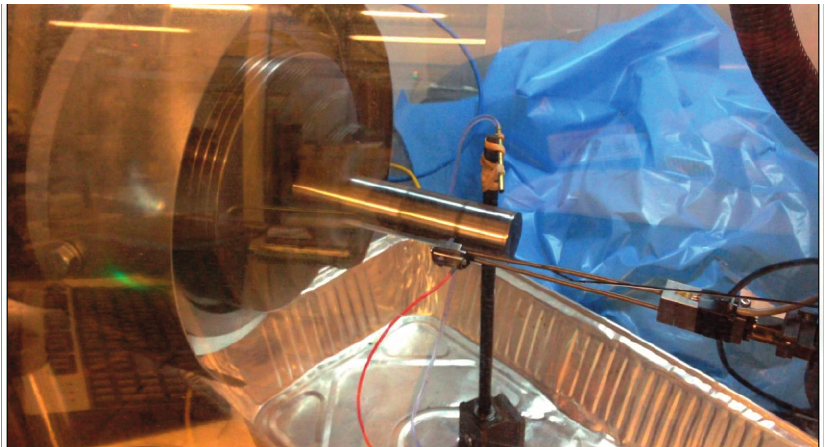
Figure 1. Robot Assisted Polishing machine.